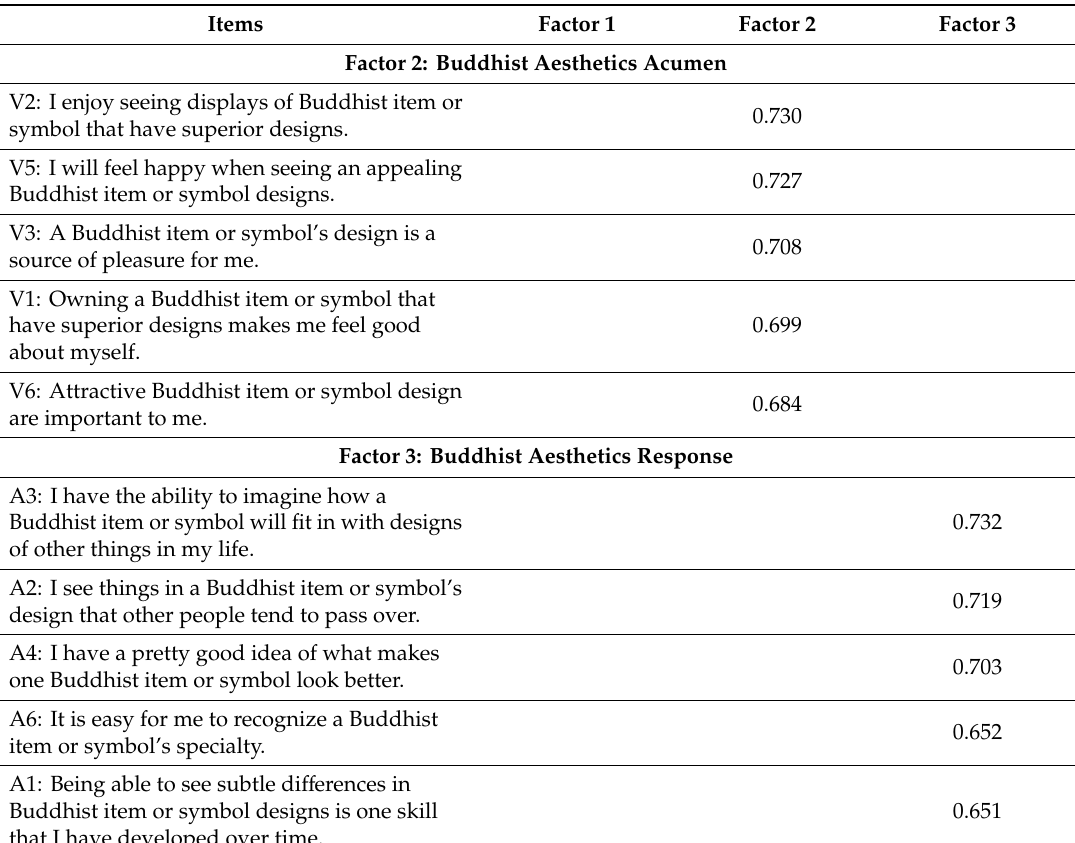
Table 3. Cont. Items Factor 1 Factor 2 Factor 3 Factor 2: Buddhist Aesthetics